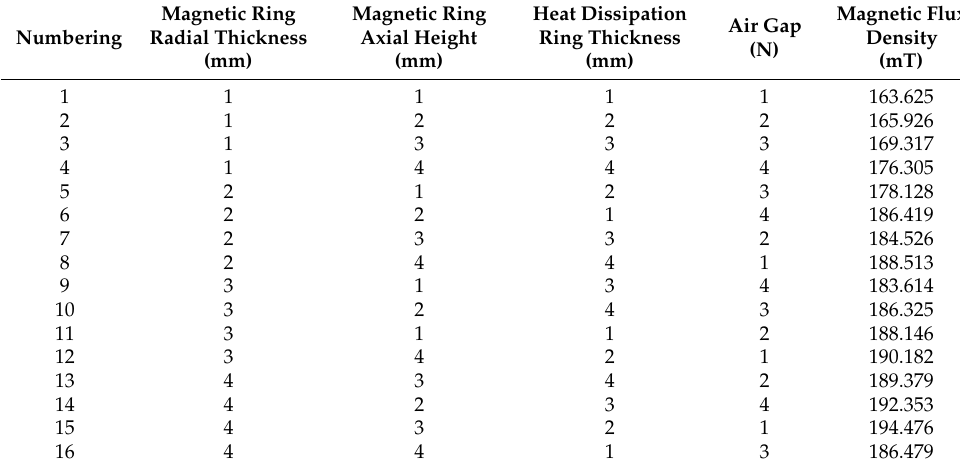
Table 2. Orthogonal test scheme and simulation results.